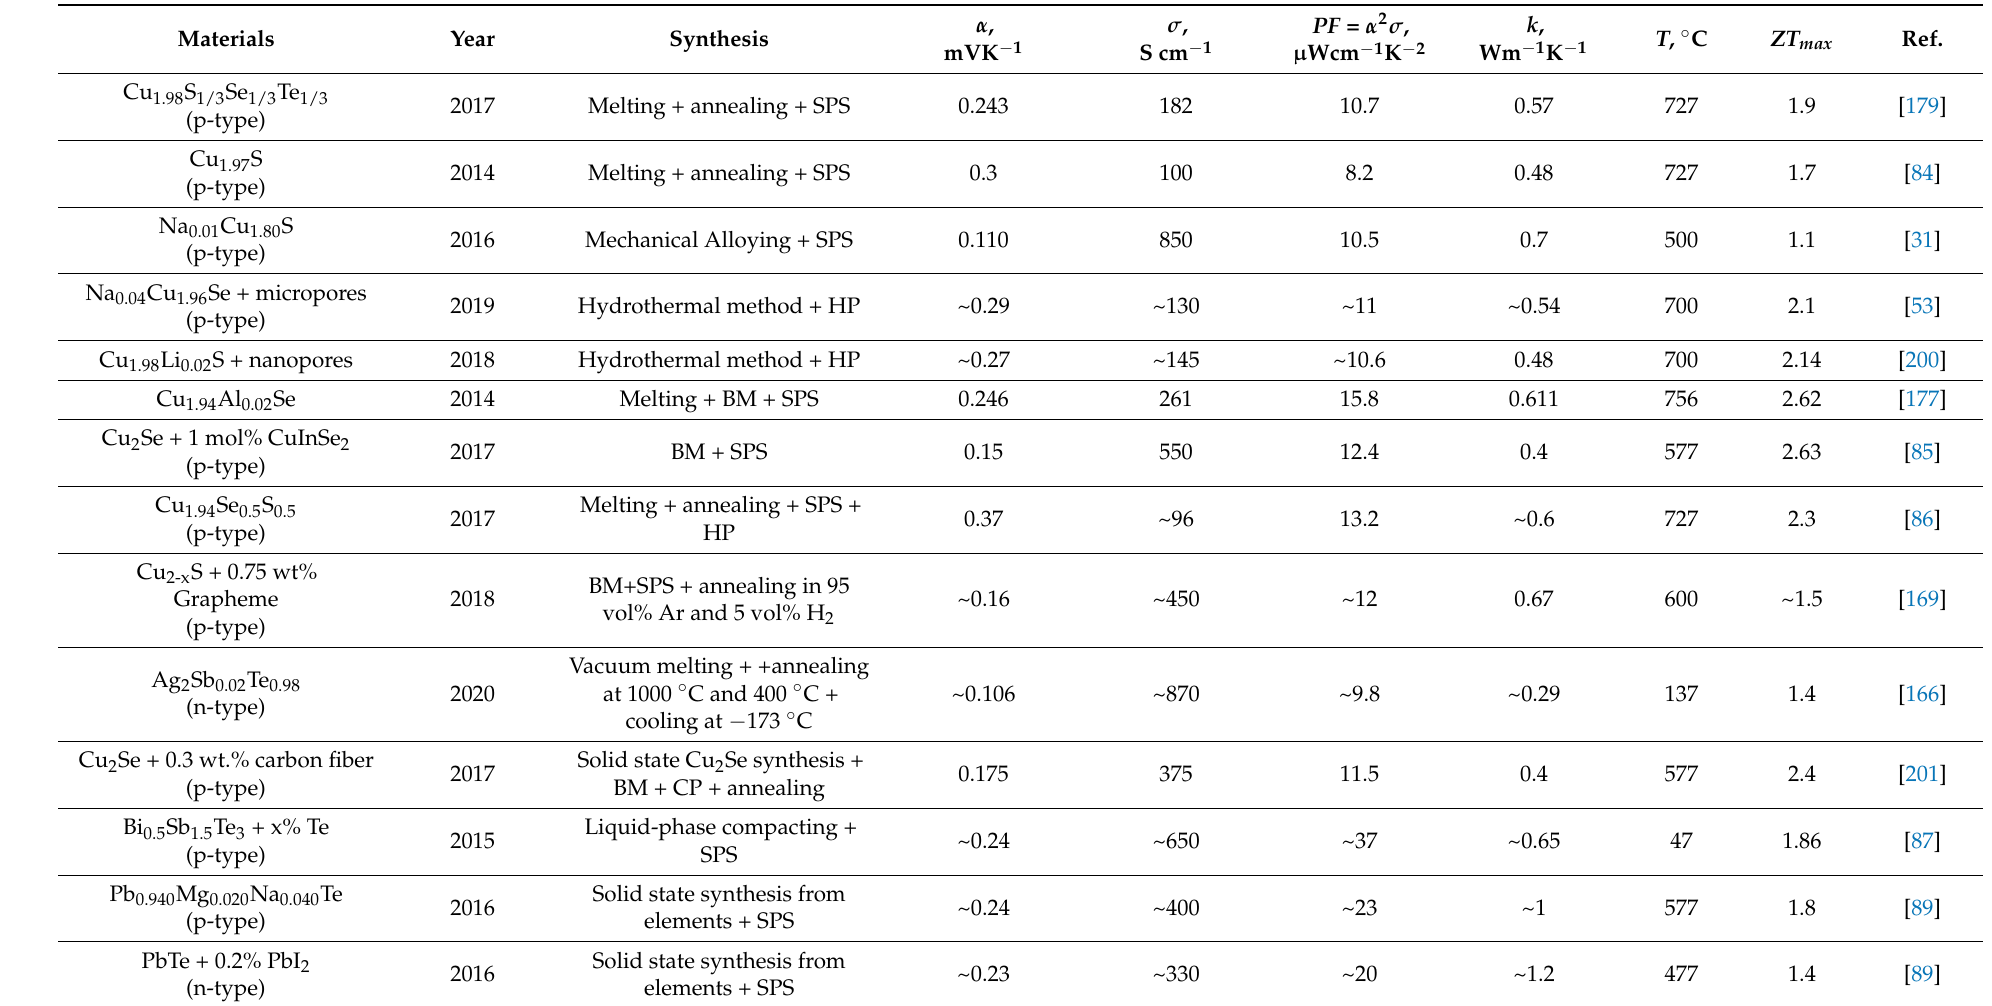
Table 2. State-of-art thermoelectric properties of some perspective